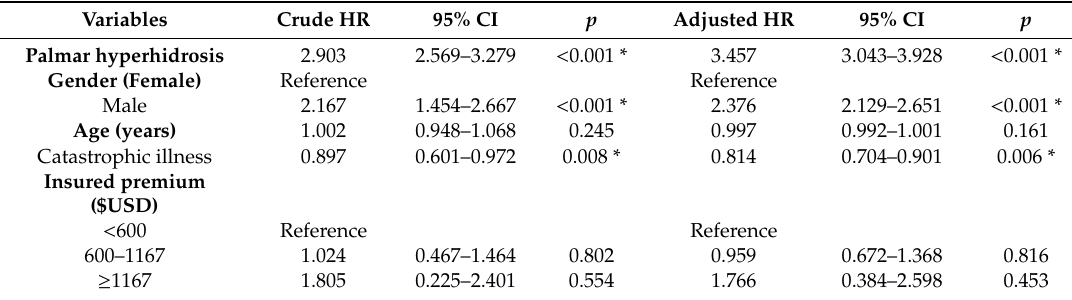
Table 2. Risk factors of reflux